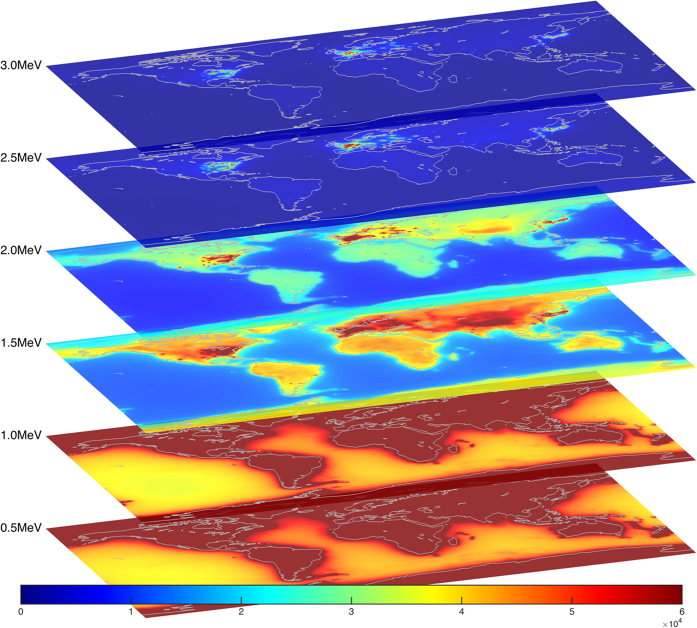
AGM2015  flux (/cm2/s/keV) displayed at 6 select energy bins out of the 1100 total AGM2015 energy bins, which uniformly span the 0 MeV–11 MeV  energy range.Each energy bin is 10 keV wide. In conjunction with 720 longitude bins and 360 latitude bins, the highest resolution AGM2015 map is a 360 × 720 × 1100 3D matrix comprising ~300 million elements total. Figure created with MATLAB45.